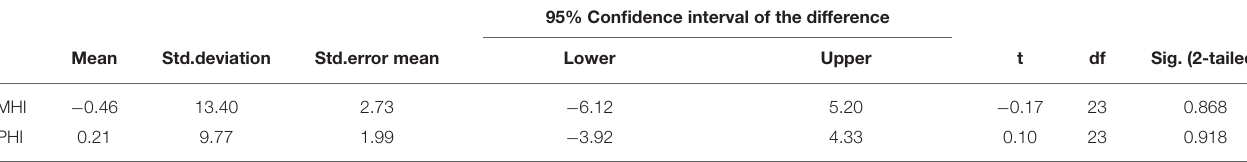
TABLE 4 | Paired samples t -test mental health index (SF-36) before and during COVID-19 pandemic. 95% Confidence interval of the